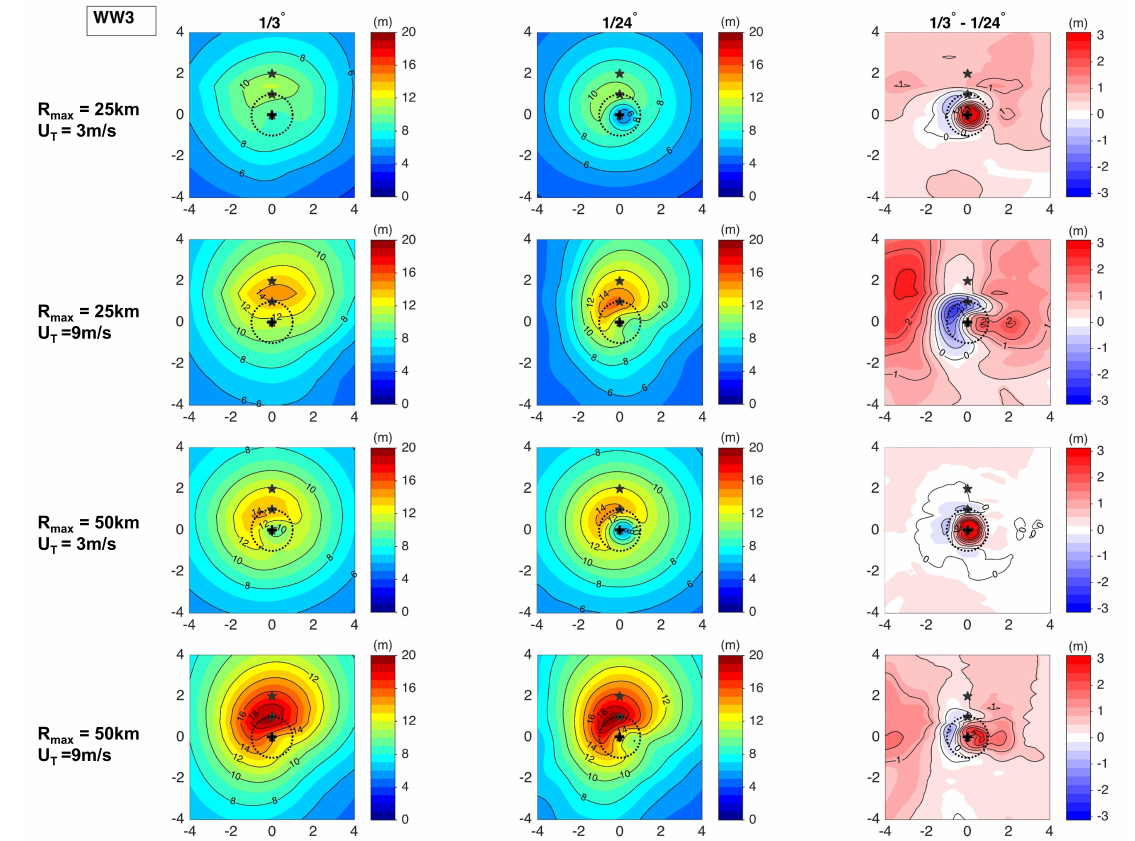
Figure 5. Spatial distribution of SWH in time-averaged quasi-steady state wave fields from WW3. The results computed: at 1/3 ◦ resolution ( left ); and at 1/24 ◦ resolution ( right ). The black contours have an increment of 3 m. The differences between the left and center columns, and the black contours are drawn every 0.5 m ( right ). Distances are normalized by R max . The black dotted circle denotes R max . Filled black stars on each panel denote the location of virtual buoys discussed in Section